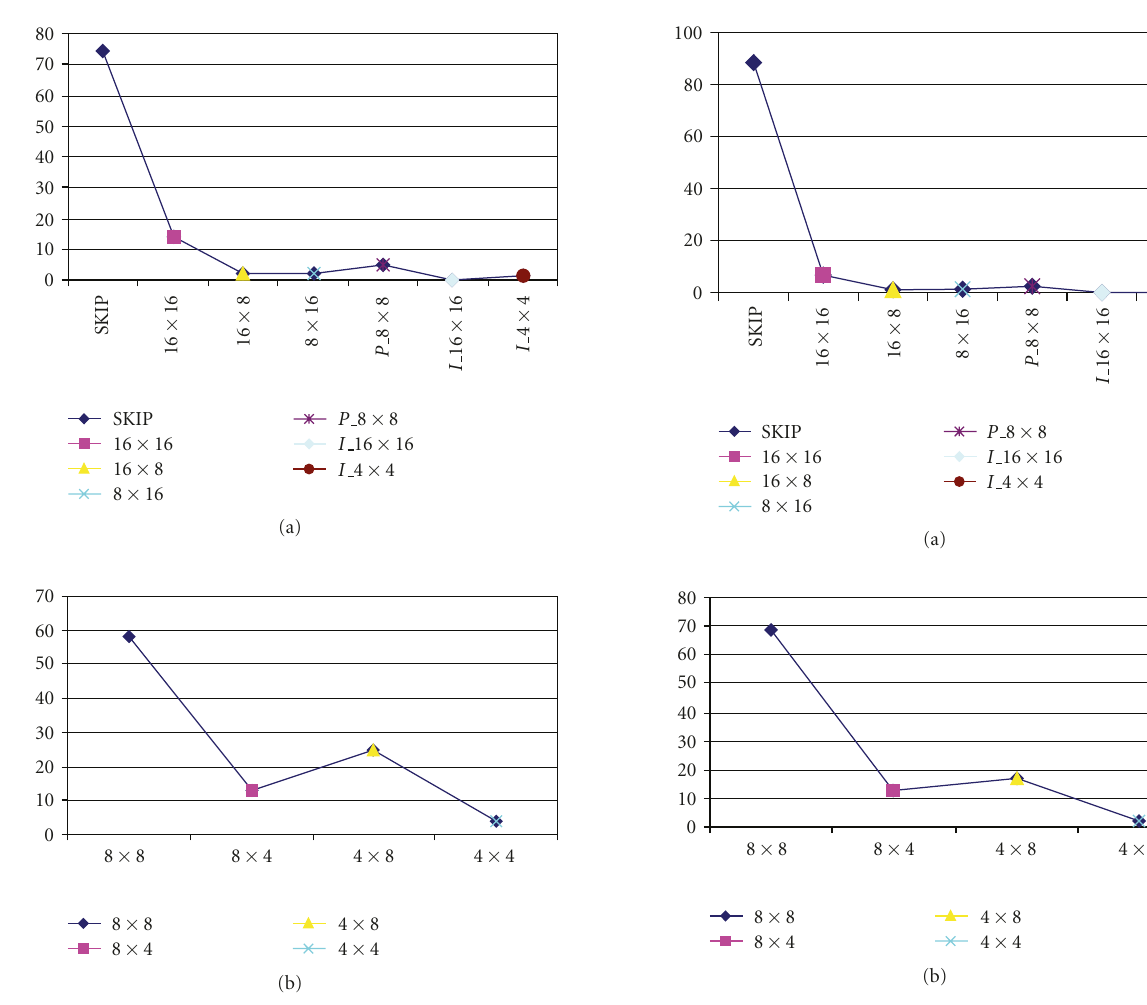
Figure 6: (a) News. (b) Sub-MB News. Figure 7: (a) Akiyo. (b) Sub-MB of